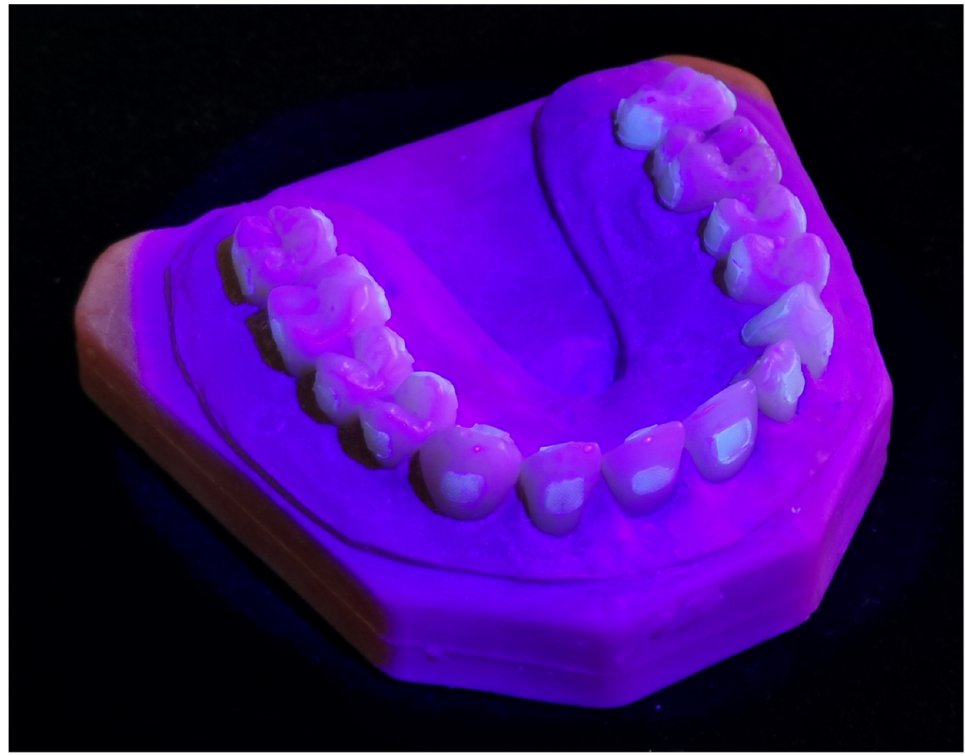
Figure 3. Upper typodont visualized with the FIT method, after bracket removal on the buccal and lingual surfaces.